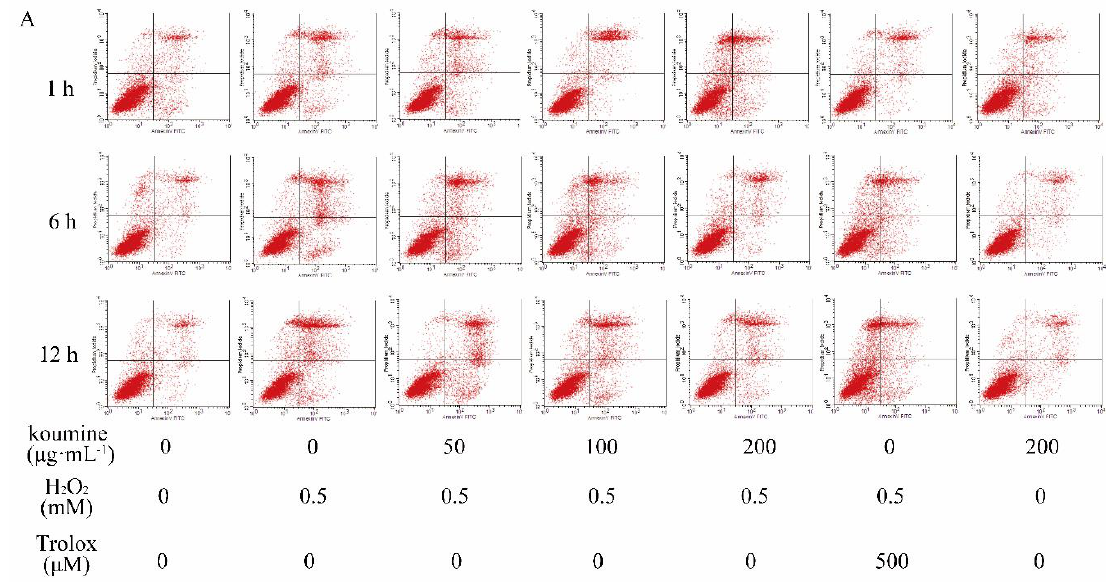
Figure 6. Effects of koumine on mitochondrial membrane potential in H 2 O 2 -induced IPEC-J2 cells. The mitochondrial membrane potential was measured using the JC-1 probe by flow cytometry. The data were expressed as mean ± s.d. ( n = 3). ## p < 0.01 vs. control group; ** p < 0.01 vs. H 2 O 2 group. ( A ) MMP was measured using the JC-1 probe by flow cytometry.; ( B ) and ( C ) JC-1 aggregates (cells emitting red fluorescence in the FL2 channel) suggested normal MMP in IPEC-J2 cells. In contrast, accumulation of JC-1 monomers monomers were respectively shown in the histograms.